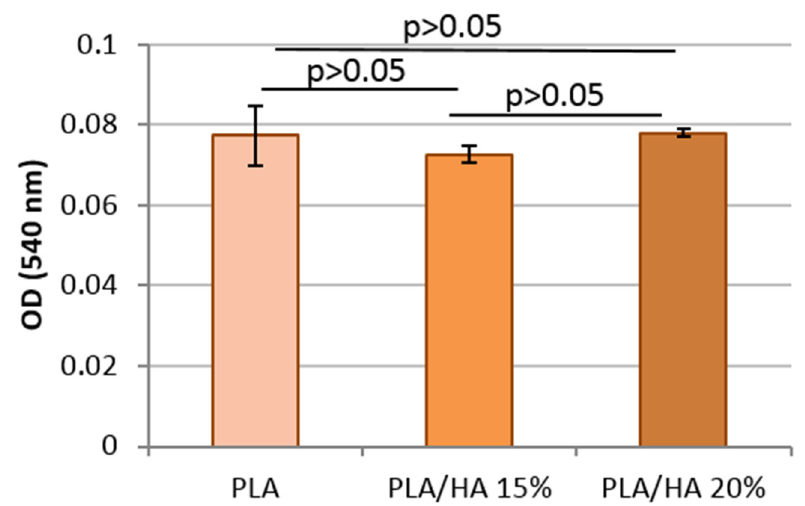
Figure 7. Formazan produced by MMSC seeded on PLA, PLA/HA 15%, and PLA/HA 20% scaffolds determined by MTT assay.